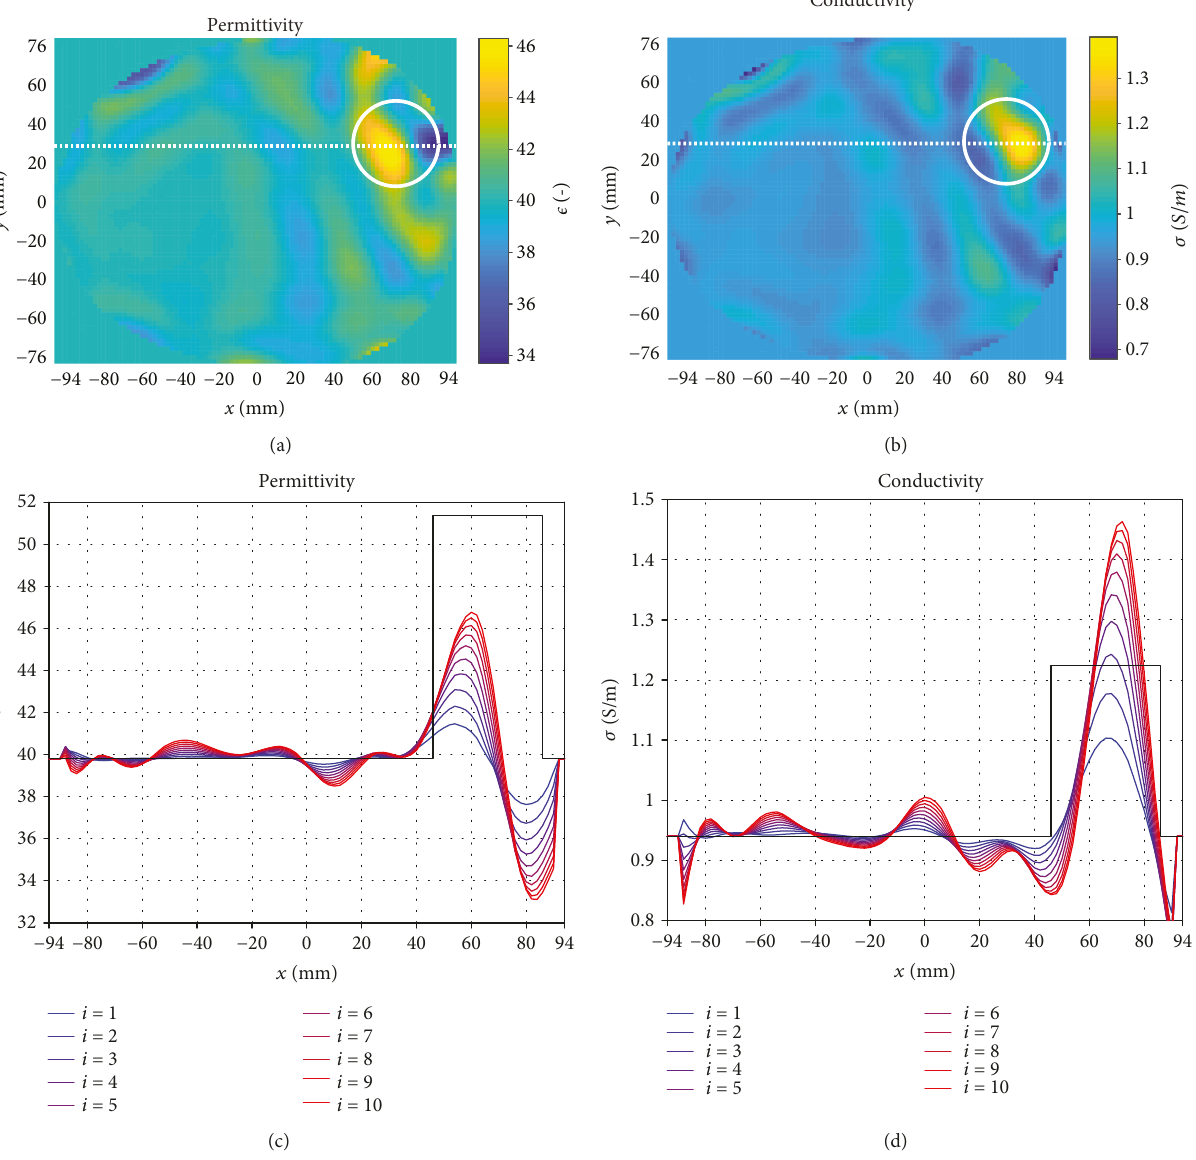
Figure 5: Results (a, b) of iterative reconstruction procedure for hemorrhagic stroke phantom at position P7 (marked by white circle) and evolution (c, d) of relative permittivity and conductivity over the iterations ( i = 1 for the fi rst iteration, i = 10 for the tenth iteration) on the line going through the center of the stroke phantom (marked by dashed white lines). Actual values of both relative permittivity and conductivity are marked by solid black lines in graphs (c) and